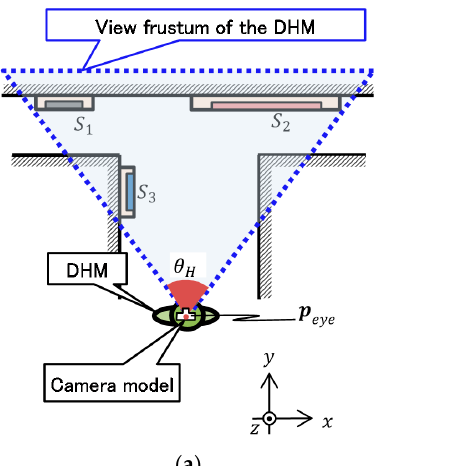
Figure 5. Signage visibility estimation: ( a ) View frustum of DHM; ( b ) image rendered using OpenGL.